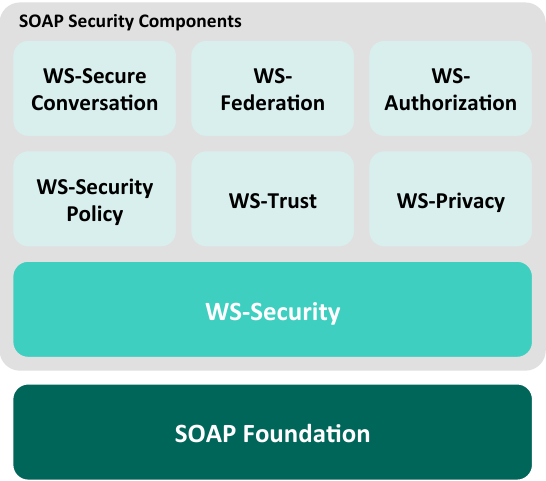
Figure 4. Security stack for SOAP-based web services